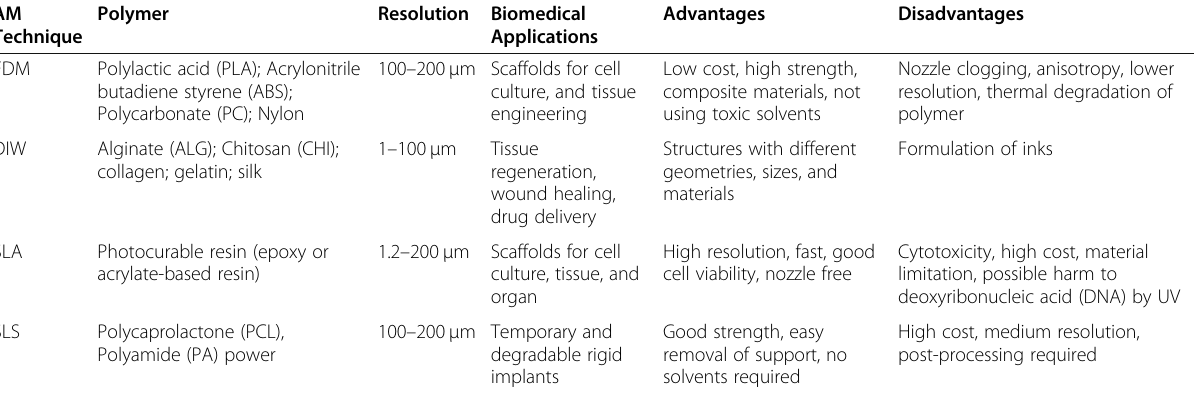
Table 1 Types of AM in biomedical applications. Adapted from [46] AM Polymer Resolution Biomedical Technique